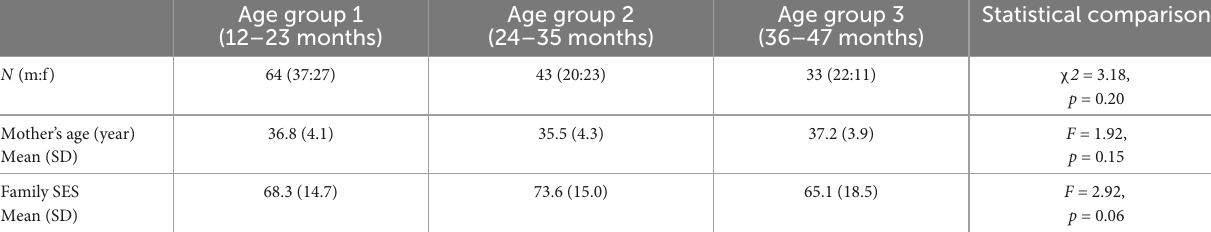
TABLE 2 Infant and maternal demographic variables for the three age